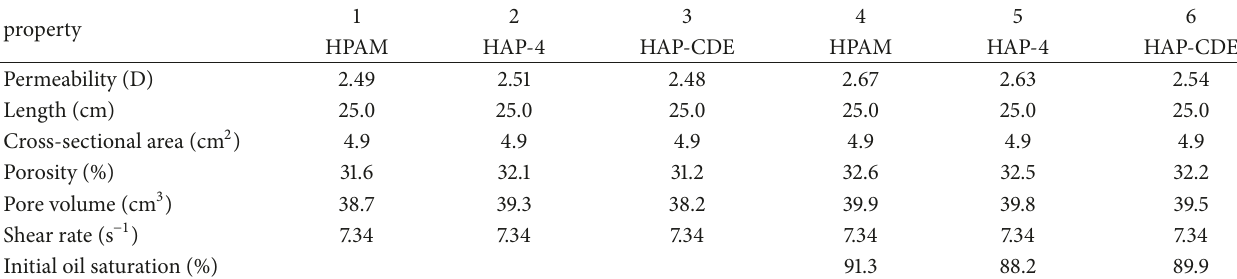
Table 1: Physical property of the sand